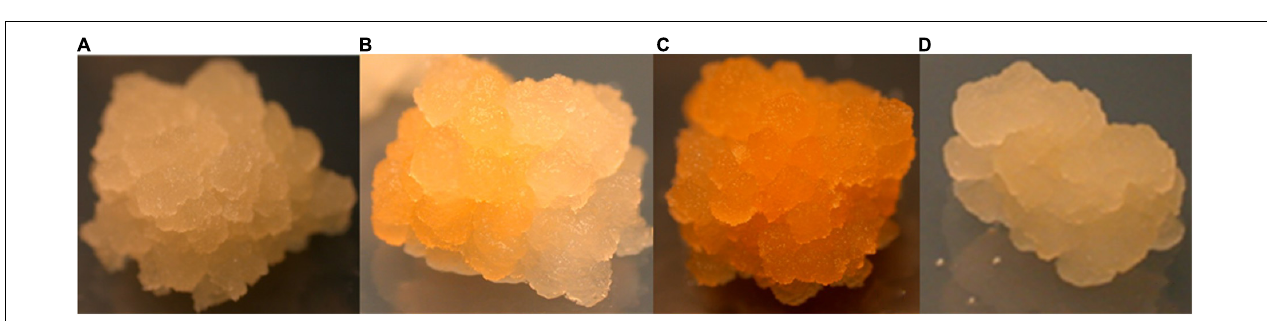
FIGURE 5 | Phytoene synthase expression in BY2 cells (A) colorless callus (B) partially colored callus (C) fully colored callus (D) colorless (callus derived from control